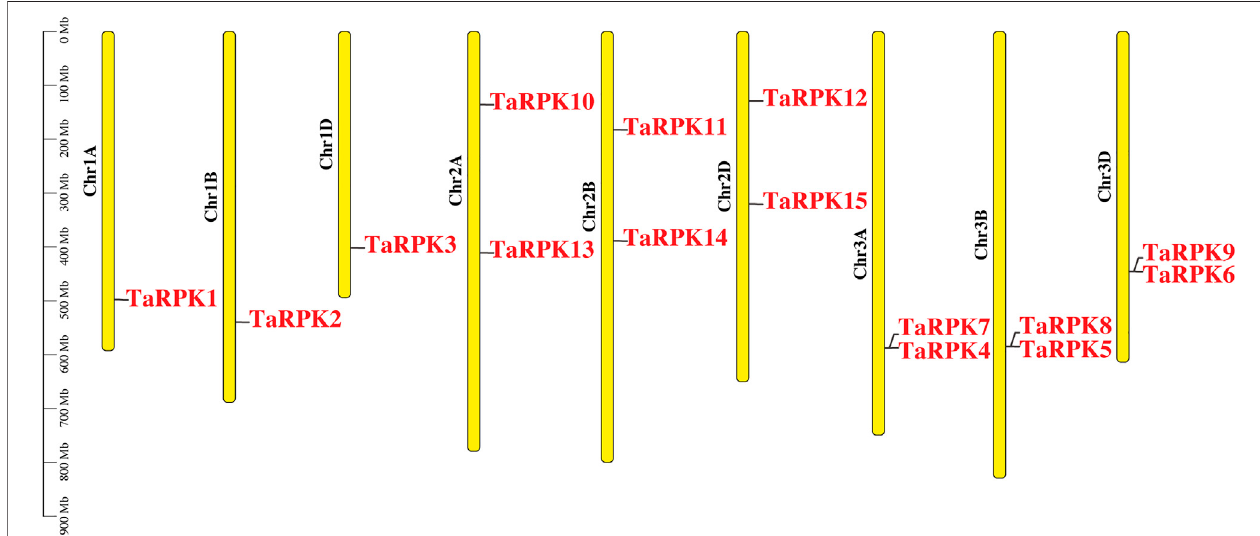
FIGURE1| Chromosomallocationof T.aestivumRPK genesonchromosomesinA,B , andDgenomes.RespectivechromosomenumbersarewrittenasChrIAto Chr 3D on the top of each chromosome. Gene position can be estimated using the scale (in megabase; Mb) on the left of the fi gure.